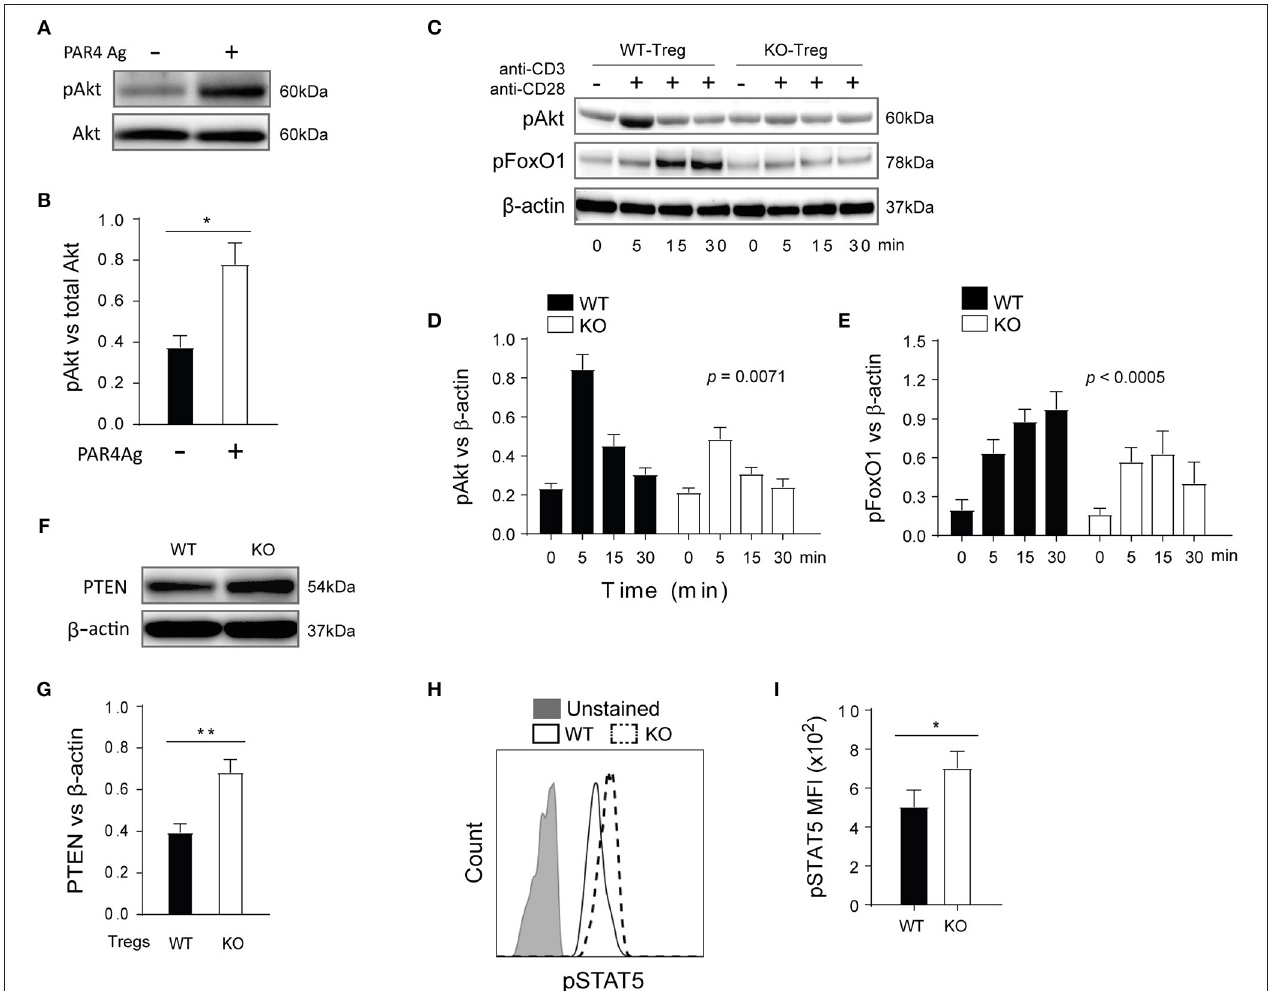
FIGURE 6 | PTEN and Akt/FoxO1 links PAR4 signaling to regulate downstream pathways in WT Treg cells. Freshly isolated WT CD4 + CD25 + Tregs were stimulated with PAR4 agonist for 15min. The levels of pAkt in these cells were analyzed by Western blots (A) and quantified against total Akt (B) . Graph shows mean ± SEM from four experiments. Data were analyzed by unpaired two-way t -test. * p < 0.05 in comparison between WT and PAR4ko Tregs. The Tregs were also activated with anti-CD3/anti-CD28 for varied time points, and the levels of pAkt and pFoxo1 analyzed in western blots (C) and quantified against beta-actin [ (D,E) , respectively]. Graphs show mean ± SEM from four experiments. Data were analyzed by two-way ANOVA. P = 0.0071 and p < 0.0005, compared between WT and PAR4ko Tregs. The level of total PTEN in the Treg cells from WT and PAR4ko mice was analyzed in Western blots (F) and quantified against beta-actin (G) . Graph shows mean ± SEM from four experiments. Data were analyzed by unpaired two-way t -test. ** p < 0.001 in comparison between WT and PAR4ko Tregs. The Tregs were also activated with IL-2 for 30min and then the MFI levels of pSTAT5 were analyzed by flow cytometry (H) and the cumulative data (I) . Graph shows mean ± SEM from three experiments. Data were analyzed by unpaired two-way t -test. * p < 0.05 in comparison between WT and PAR4ko